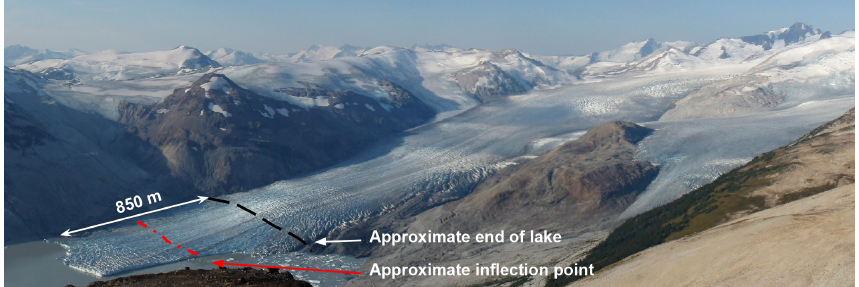
Figure 4. Photograph of Bridge Glacier terminus in September 2013, showing the approximate location of the inflection point and of the proximal edge of Bridge Lake.